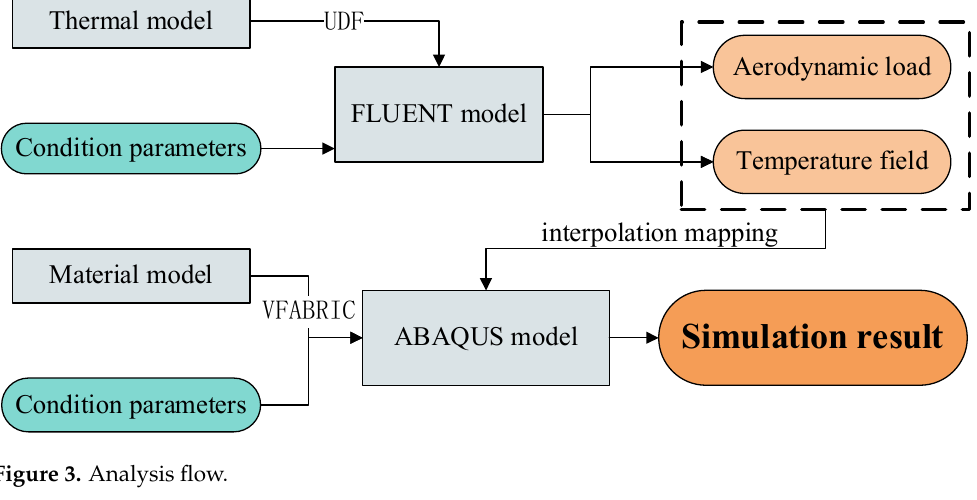
Figure 3. Analysis flow.